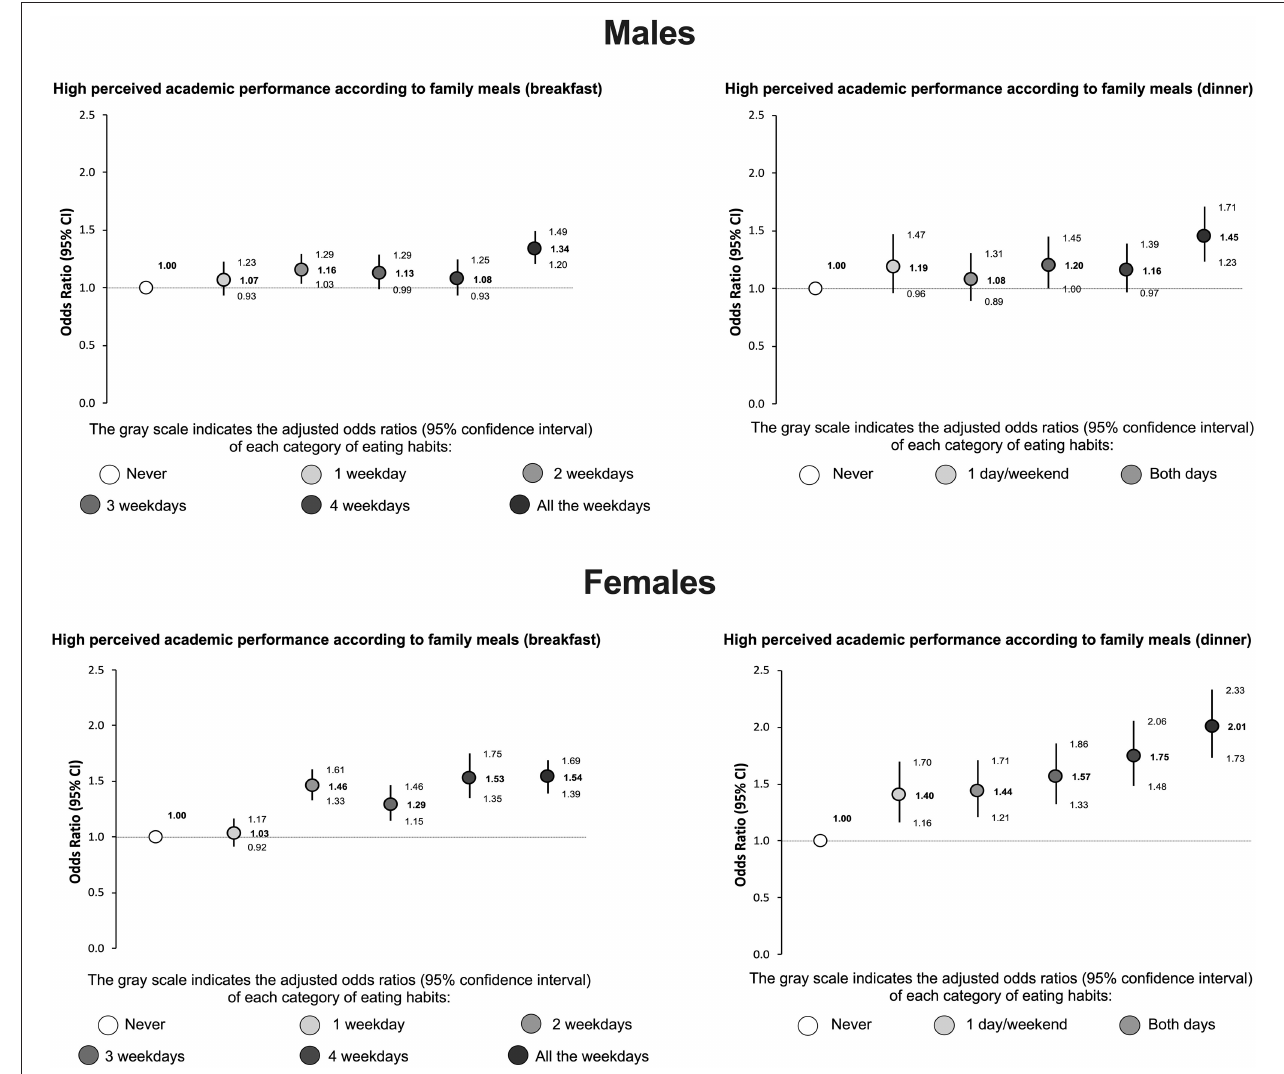
FIGURE 3 | Association between high perceived academic performance and frequency of family meals (breakfast and dinner) among adolescents. Odds ratios generated using logistic regression models adjusted by region, age, body mass index (z-score), socioeconomic status, physical activity, recreational screen time, and sleep